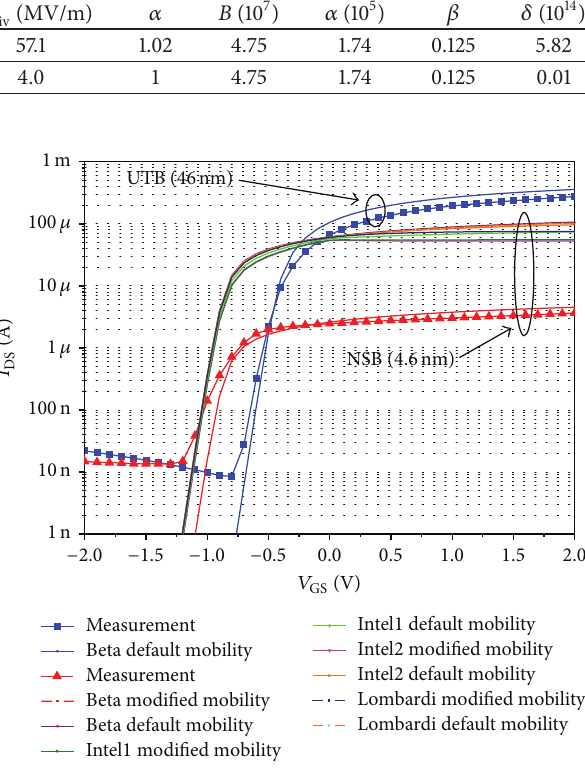
Figure 5: 𝐼 DS - 𝑉 GS (semilog) for experimental and simulation data. The presented NSB’s 𝐼 DS - 𝑉 GS are based on all the available field dependent mobility models in TCAD device simulator. Default and changed parameters are presented in Table 2. 𝑉 DS is fixed to 0.1